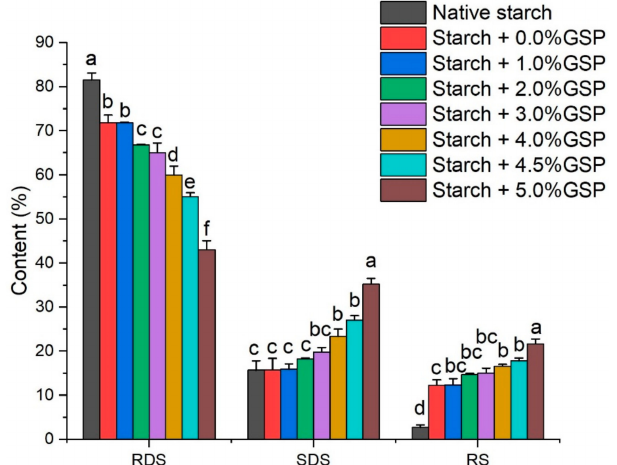
Figure 4. E ff ect of GSP–potato starch interactions on digestible properties of native starch and GSP-potato starch complexes. RDS, SDS, and RS represent rapidly digestible starch, slowly digestible starch, and resistant starch, respectively. Error bars indicate ± standard deviation. The same letters within starch digestibility types are not significantly di ff erent ( p <